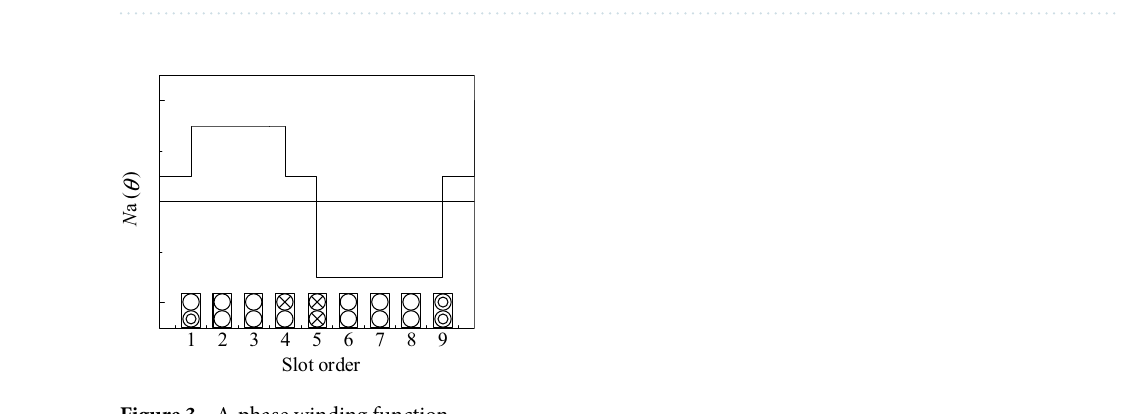
Table 2. Main parameters of four kinds of magnetic field modulation PM machines.